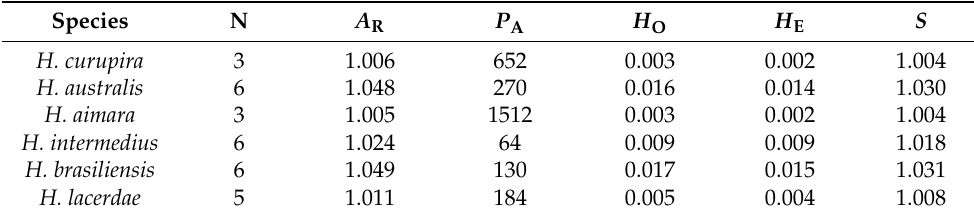
Table 2. Comparative genetic diversity levels among Hoplias aimara and Hoplias lacerdae species groups. N, number of samples; A R , allelic richness; P A , private alleles; H O , observed heterozygosity; H E , expected heterozygosity; S , Shannon diversity. Species N A